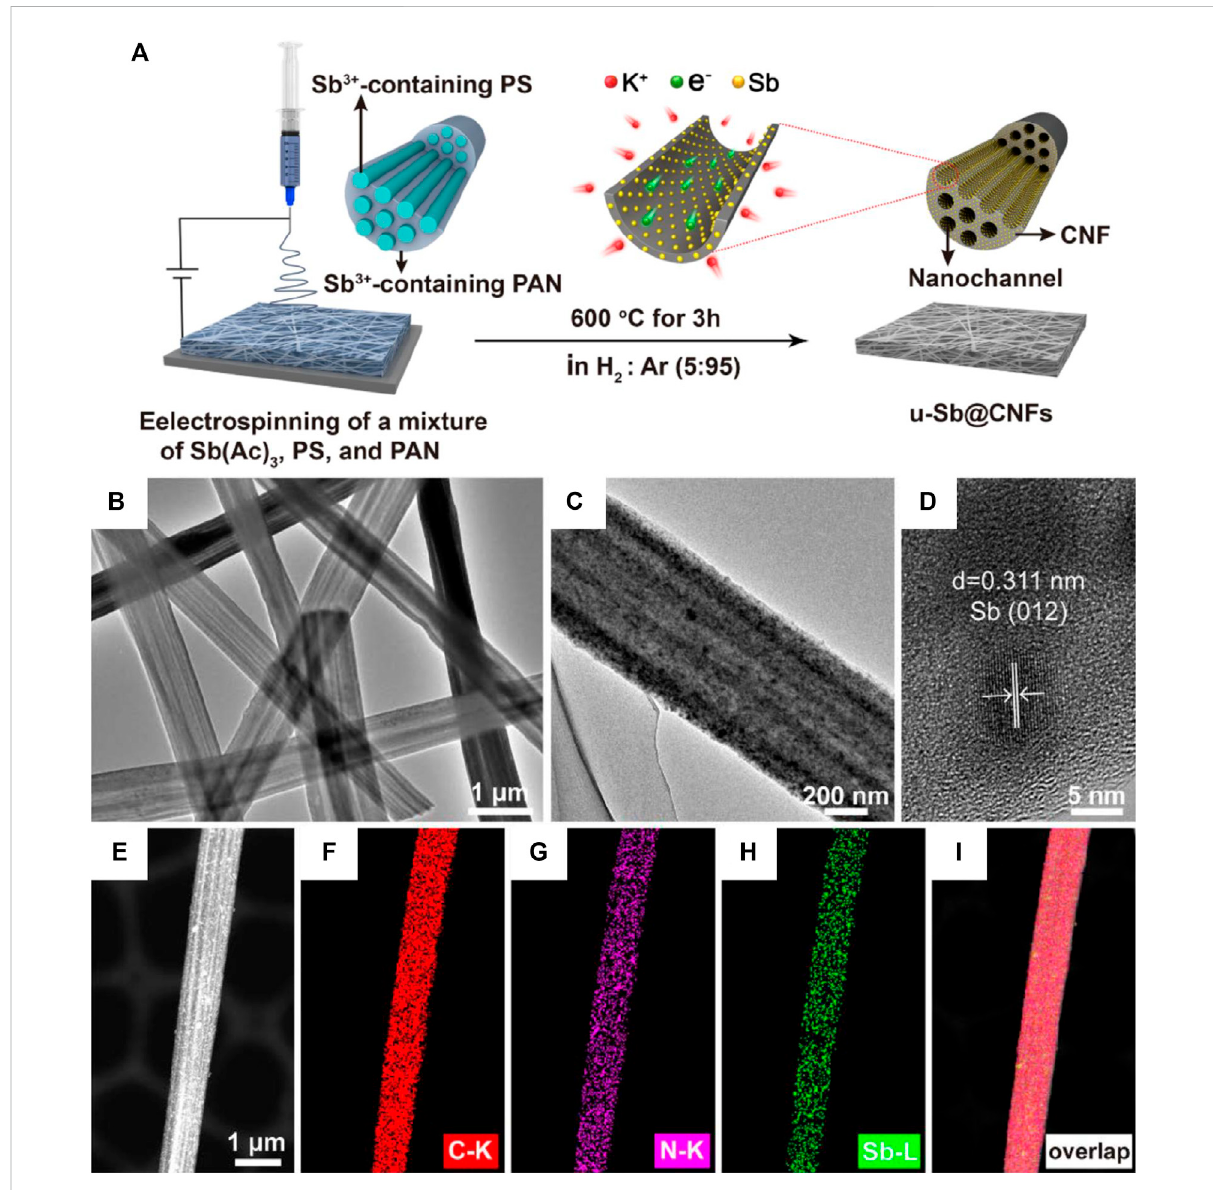
FIGURE 6 (A) Schematicillustrationofasimpletwo-steproutetoultrasmallSbnanocrystals-impregnatedcarbonnano fi berscontaininganarrayofhollow nanochannels (denoted u-Sb@CNFs). (B) and (C) TEM images, (D) HRTEM image, and (E – I) the corresponding elemental mappings of u-Sb@CNFs. (Ge et al.,